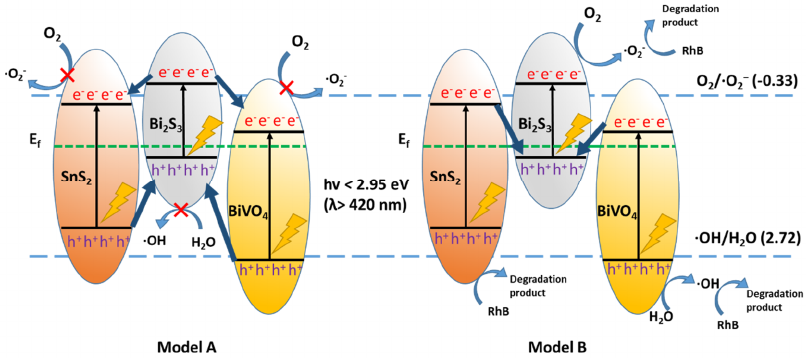
Figure 8. Proposed charge-transfer pathway models and RhB degradation mechanism of BiVO 4 /Bi 2 S 3 /SnS 2 under visible light illumination.